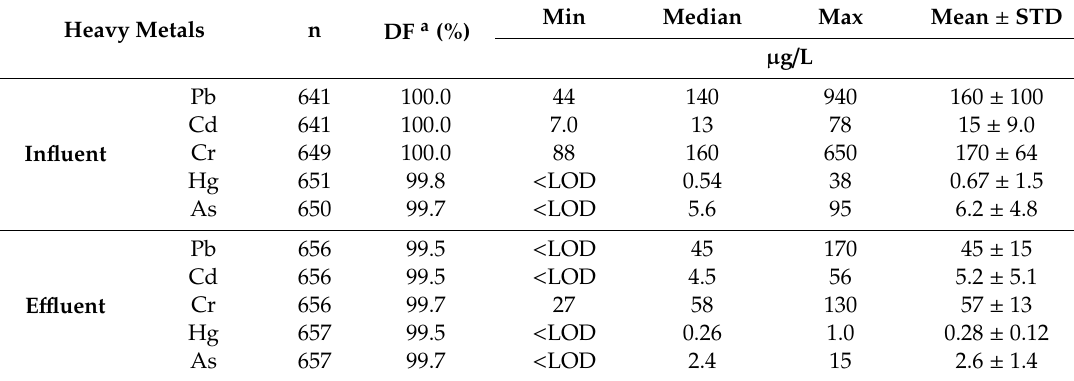
Table 1. Statistics of heavy metals concentration in municipal wastewater